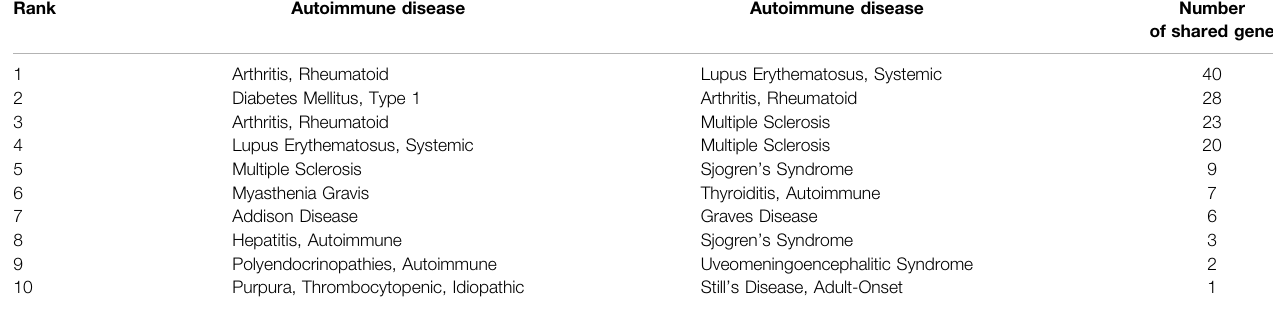
TABLE 1 | The ten potential pairs of similar ADs ranked by number of shared genes.